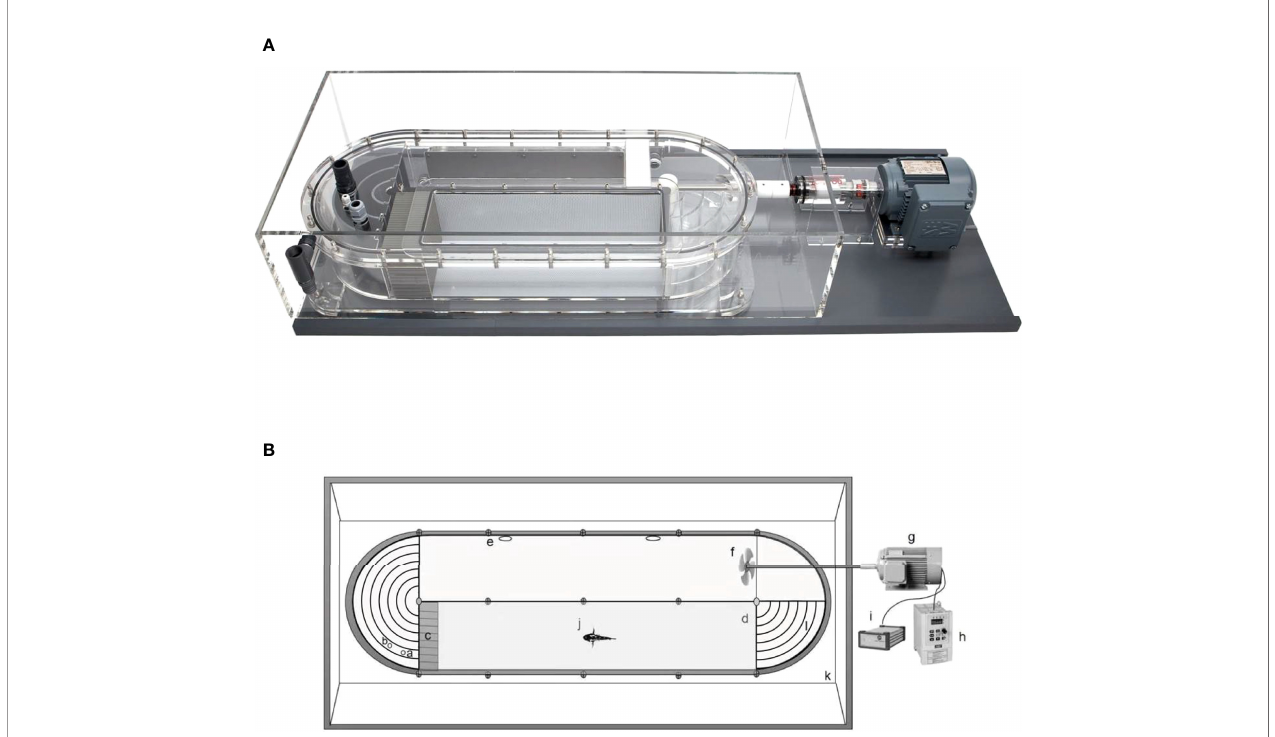
FIGURE 3 | (A) Design of the swim tunnel (Loligo Systems SW10150). Copyright: Loligo Systems, Viborg, Denmark, https://www.loligosystems.com/, published with permission. (B) Top view. a: dissolved oxygen probe; b: temperature probe; c: honeycomb fl ow stabilizer; d: testing chamber; e: water exchanging hole; f: propeller; g: electric motor; h: frequency converter; i: data collector module (DAQ-BT); j: experimental fi sh; k: acrylic plastic board; l: water fl ow de fl